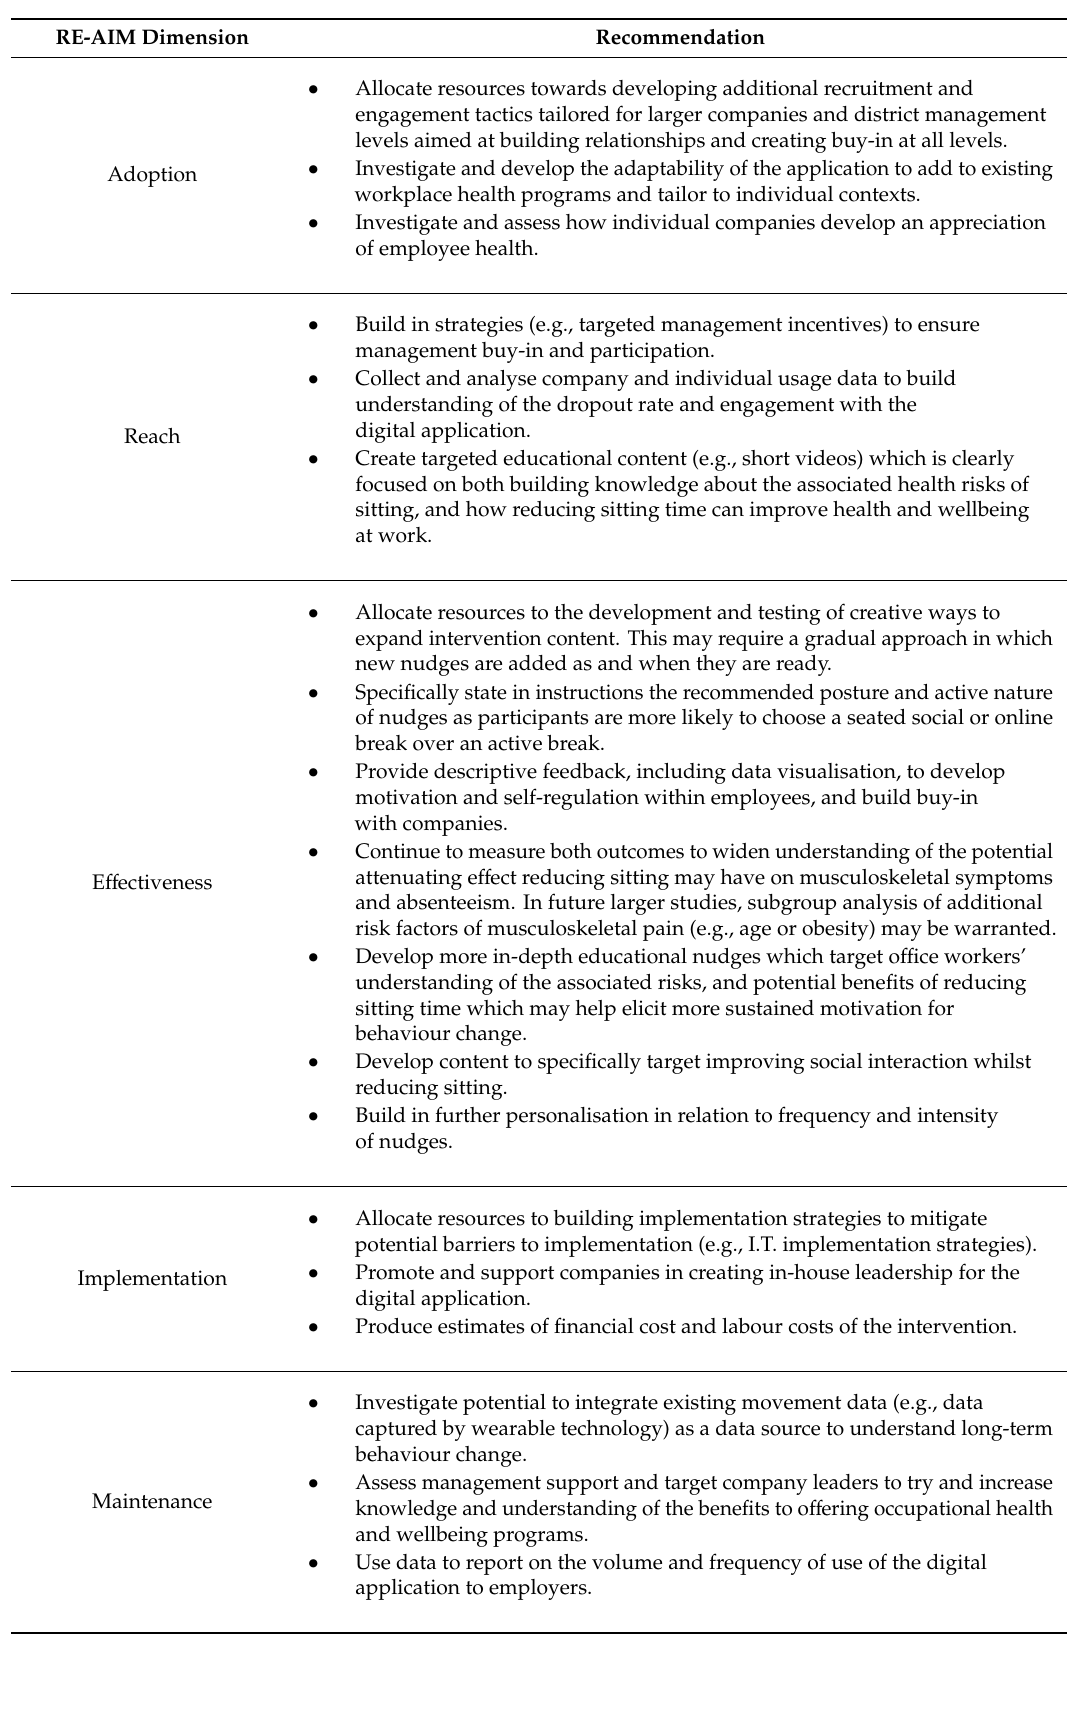
Table 12. Recommendations to improve a digital application’s reach, e ff ectiveness, adoption, implementation and